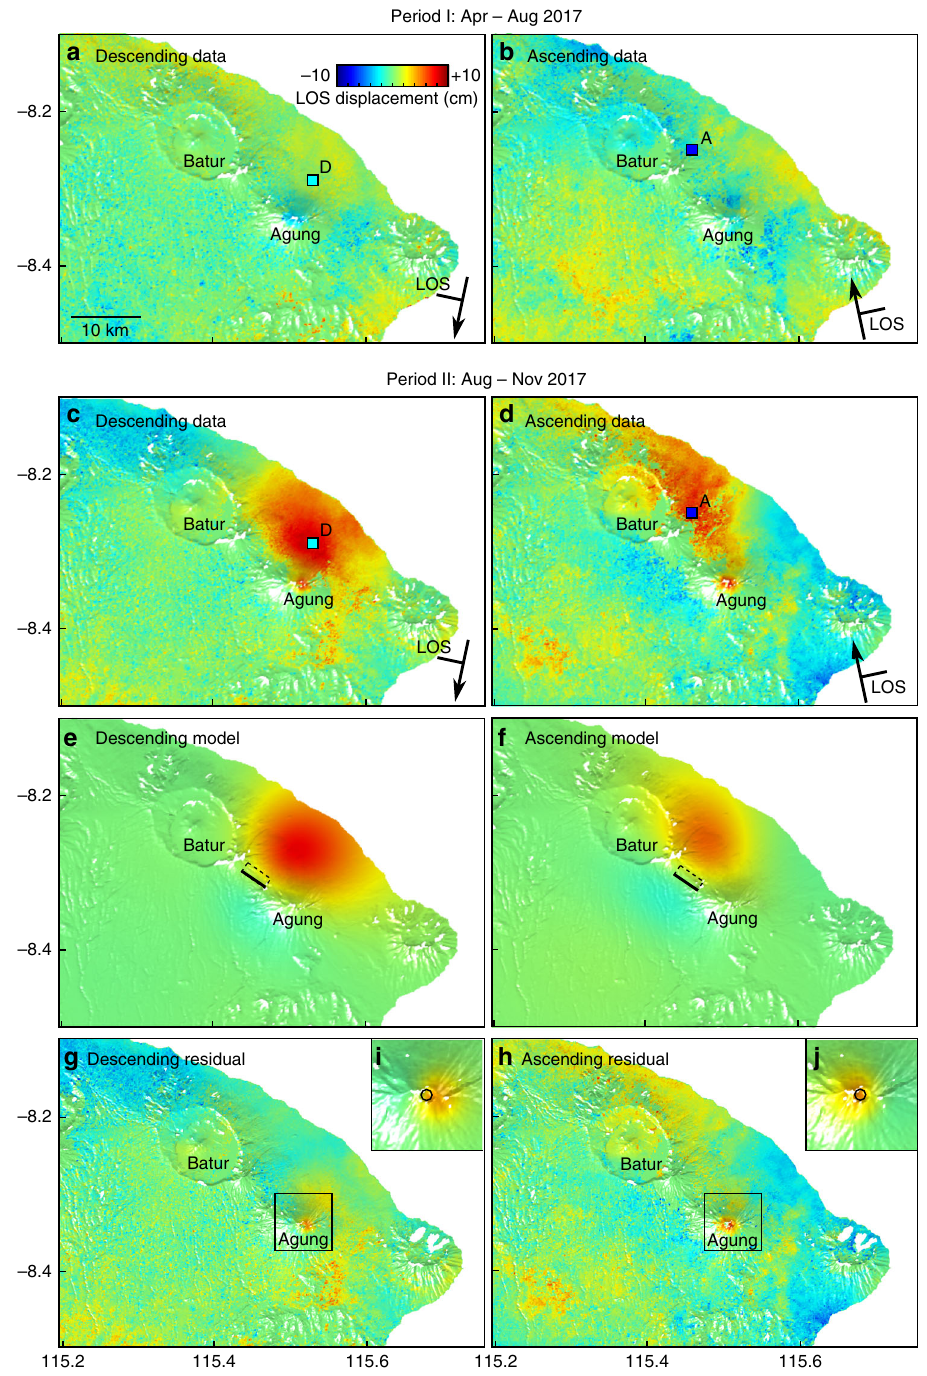
Fig. 3 Ground deformation signals detected around Agung and Batur volcanoes. a – d Surface deformation maps are derived from stacked and corrected Sentinel-1 interferograms (see Methods). a , b period I from April to August 2017, showing no signi fi cant ground displacements and c , d period II from August to November 2017, showing a wide ground uplift on the northern fl ank of Agung. e , f Model displacement for the period II: best- fi t model is a deep dyke intrusion located between Agung and Batur (black rectangle with bold line being the top edge). g , h Residual displacements obtained after removing the signal induced by the intrusion model. Both tracks show a residual uplift signal on Agung summit (black square), which has been modelled by i , j a small spherical source located 1 km below the edi fi ce summit (~2 km above sea earthquakes detected by the regional network (4.3 × 10 16 Nm) is an order of magnitude less than the geodetic moment release (5.7 × 10 17 Nm) as is typical for dyke intrusions 14,34 . The ratio between the inferred intruded volume and the cumulative seismic moment is similar to that found for other volcano-tectonic earthquake swarms 2 .